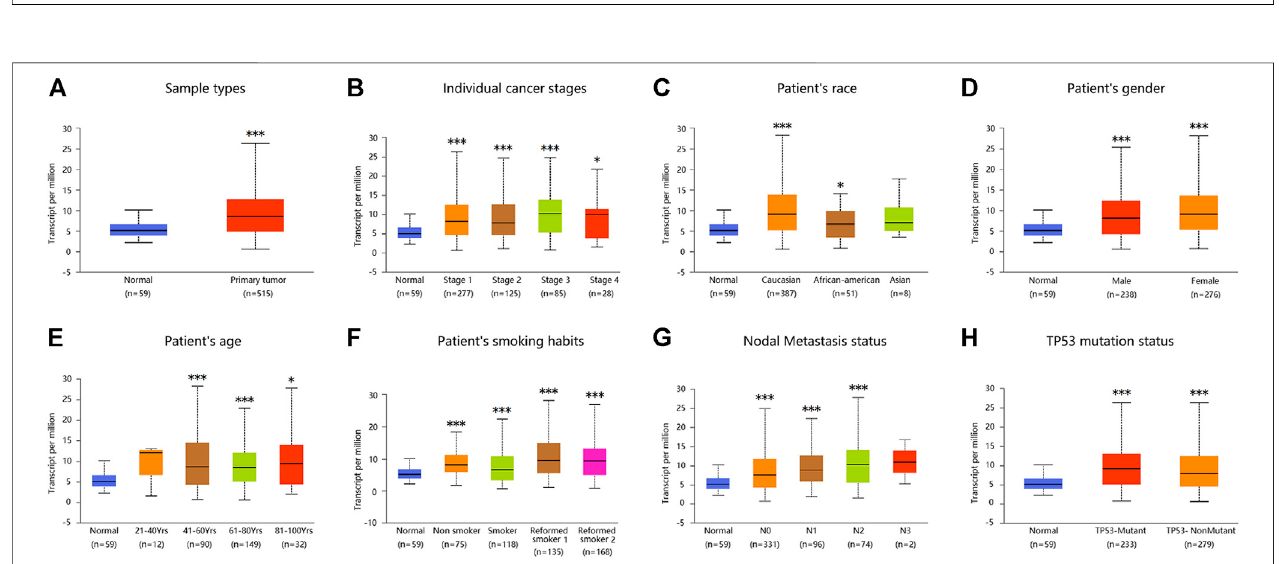
FIGURE 2 | ADORA2B expression level in subgroups of patients with LUAD. Relative expression of ADORA2B in normal and different classi fi cations of LUAD tissues. (A) Sample types, (B) individual cancer stages, (C) patient ’ s race, (D) patient ’ s gender, (E) patient ’ s age, (F) patient ’ s smoking habits, (G) nodal metastasis status, and (H) TP53 mutation status. * p < 0.05 and *** p < 0.001 are statistically signi fi cant.